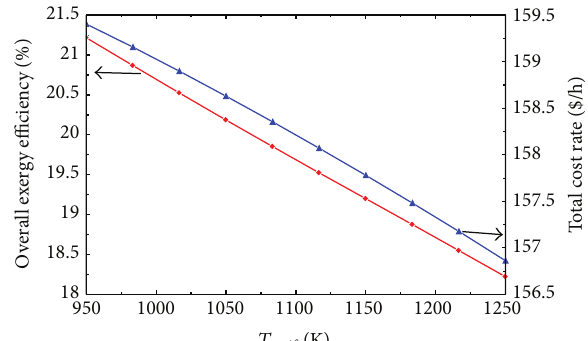
Figure 3: The impact of the gasification temperature on the objective functions.